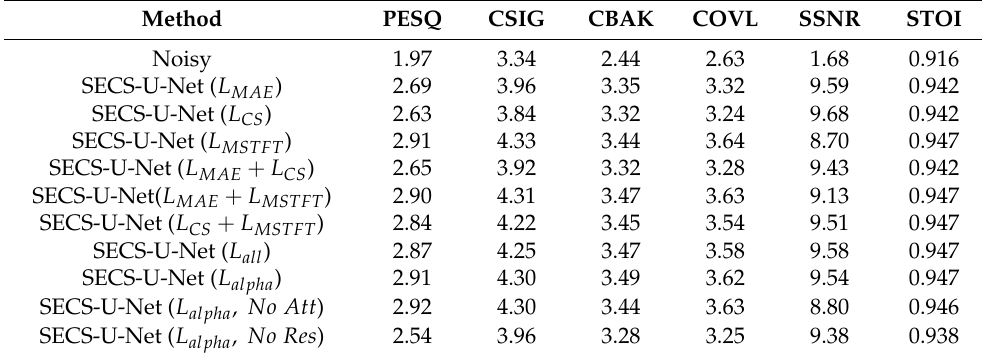
Table 2. Ablation experiment of different